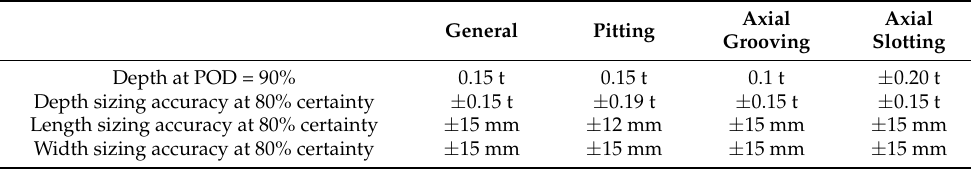
Table 2. Inspection accuracy of circumferential magnetic flux leakage tool.